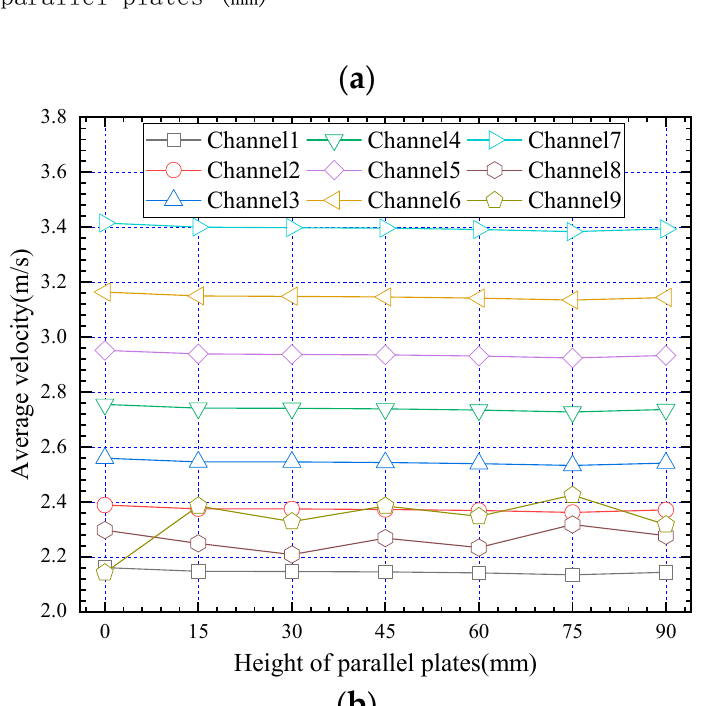
model under various installation height of parallel plates; ( b ) airflow distribution of the